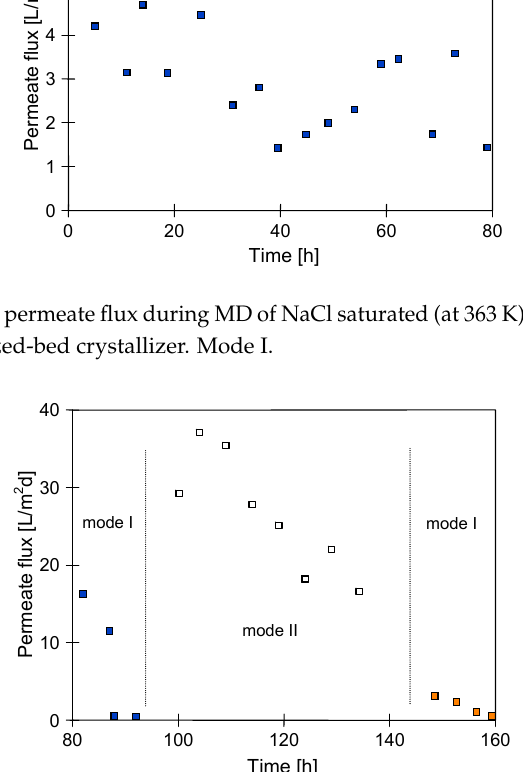
Figure 5. Changes of the permeate flux during MD of NaCl saturated (at 363 K) solutions. Module MD2 assembled inside fluidized-bed crystallizer. Mode I—continuous feed concentration, mode II—feed concentration with periodical membrane rinsing with distilled water.